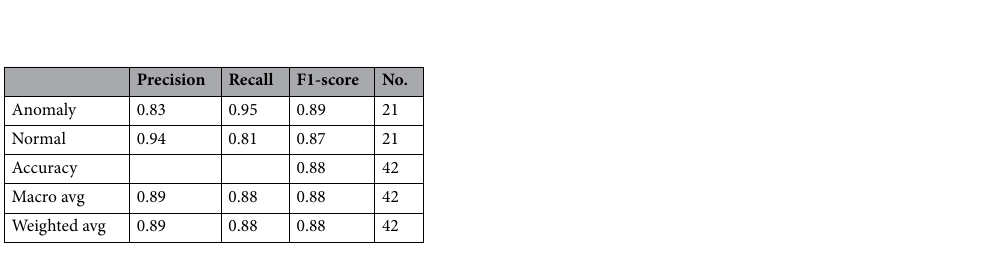
Table 8. The classification results of CNN and attention-based LSTM using Leaky ReLU on the original drill dataset. No. indicates the number of samples.